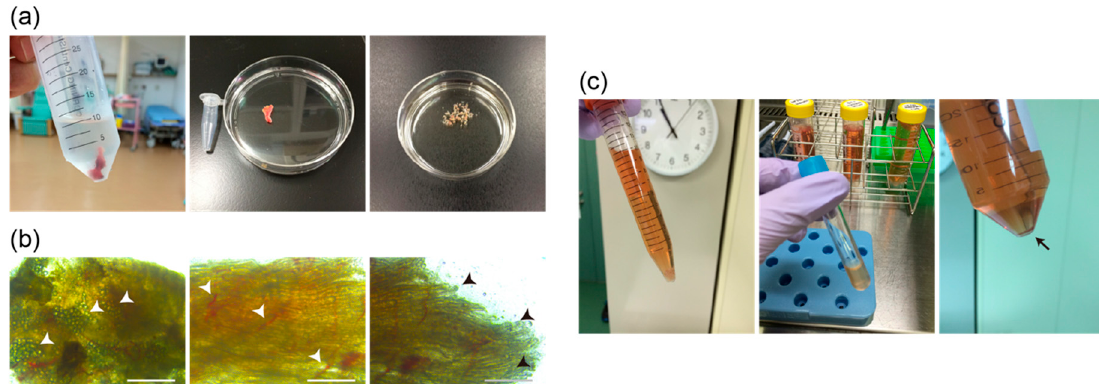
Figure 2. The schematic representation of collecting human skeletal muscle cells obtained from extra tissues containing orbicularis oculi muscles at the time of ophthalmic surgery. ( a ) Surgically excised eyelid tissues soaked in cold PBS solution (left panel), an example of the actual size of the extra eyelid tissue compared with a 1.5-mL microtube (middle panel), and the obtained tissue finely chopped by scissors (right panel). ( b ) Morphological features of isolated tissues, mass of lipids (arrowheads in left panel), blood capillaries (arrowheads in middle panel), and disconnected skeletal muscle fibers (arrowheads in right panel). Scale bars, 200 µ m. ( c ) Chopped samples were enzymatically treated with collagenase type 2 (left panel), then filtrated after enzymatic digestion (middle panel), and centrifuged to collect single myogenic cells (arrow, right